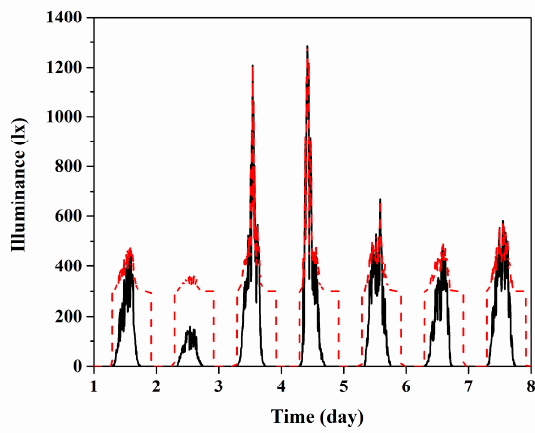
Figure 10. Comparison of PMV (—: scenario 2 A, - -: scenario 2 B, and —- -: scenario 2 C).